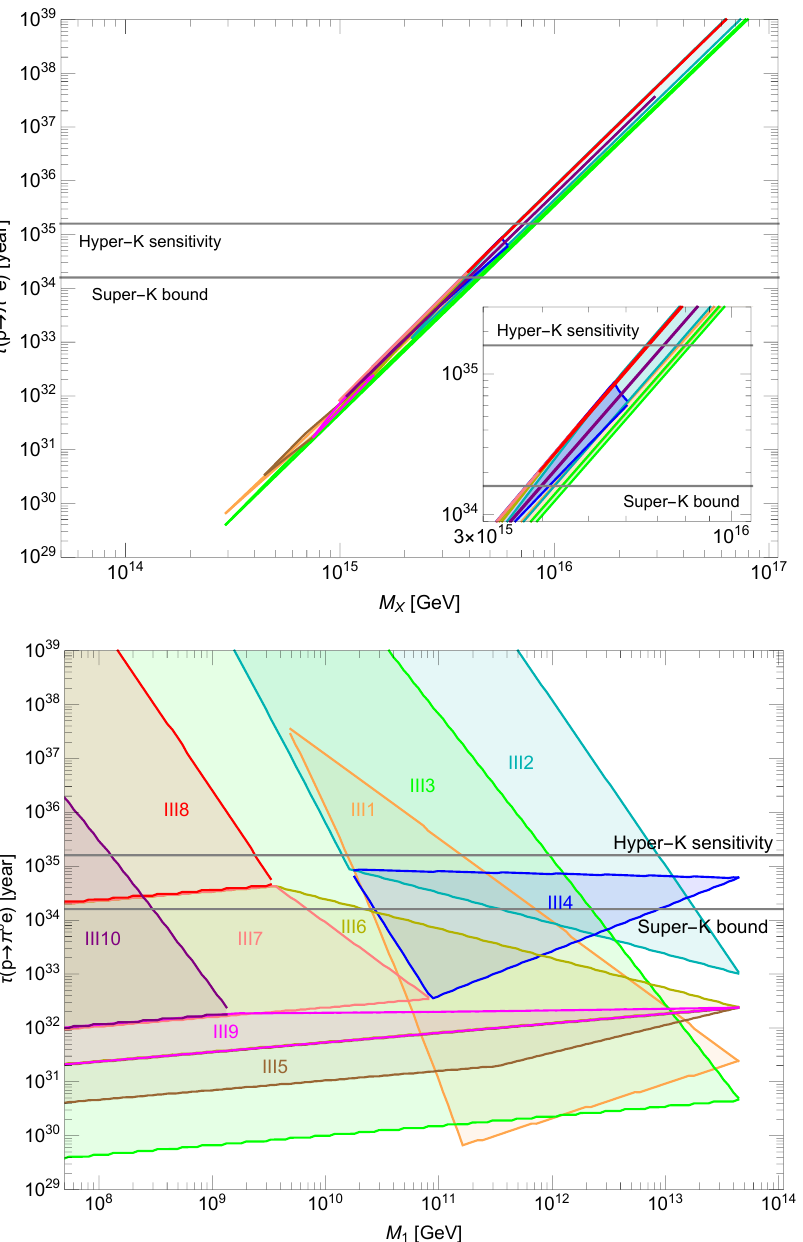
Figure 5 . Predictions of the proton decay lifetime as a function of the GUT scale, M X , and intermediate scale, M , in breaking chains cIII1-10. The colour for each chain is specified in both 1 the upper and low panel. Labels for each chains in the upper panel are not shown as regions for these chains overlap